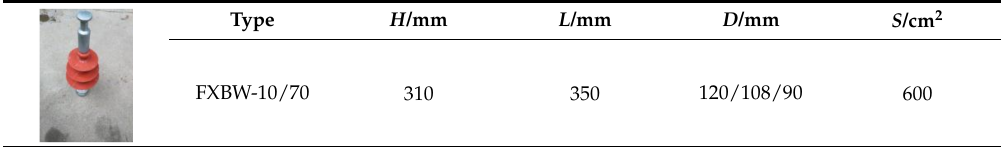
Table 1. Technical parameters of the FXBW-10/70 composite insulator.